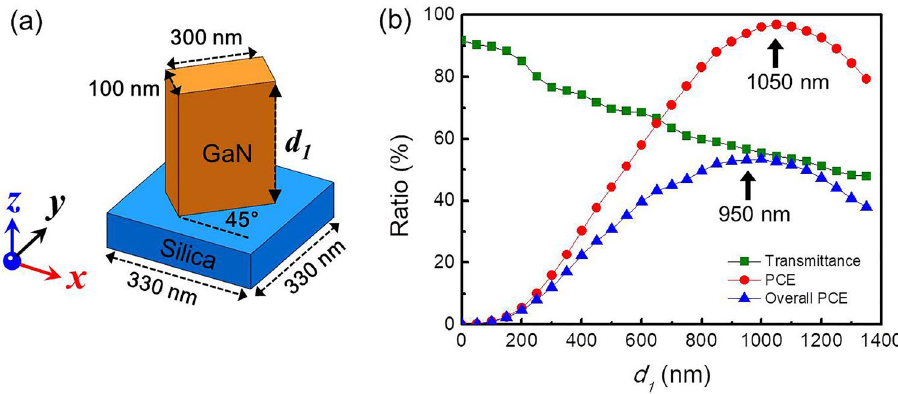
Figure 1. Geometric diagram and optical property of GaN nano-fin. ( a ) Geometric diagram of a GaN nano-fin on a silica substrate, where d 1 is the thickness of the nano-fin. ( b ) Transmittance, PCE, and overall PCE versus the thickness of the nano-fin under light illumination of 633 nm at normal incidence along the z-direction from bottom to up. The polarized light is along the x-direction. The light is x-polarized, with λ = 633 nm. The light impinges perpendicularly onto the structure from bottom along the positive